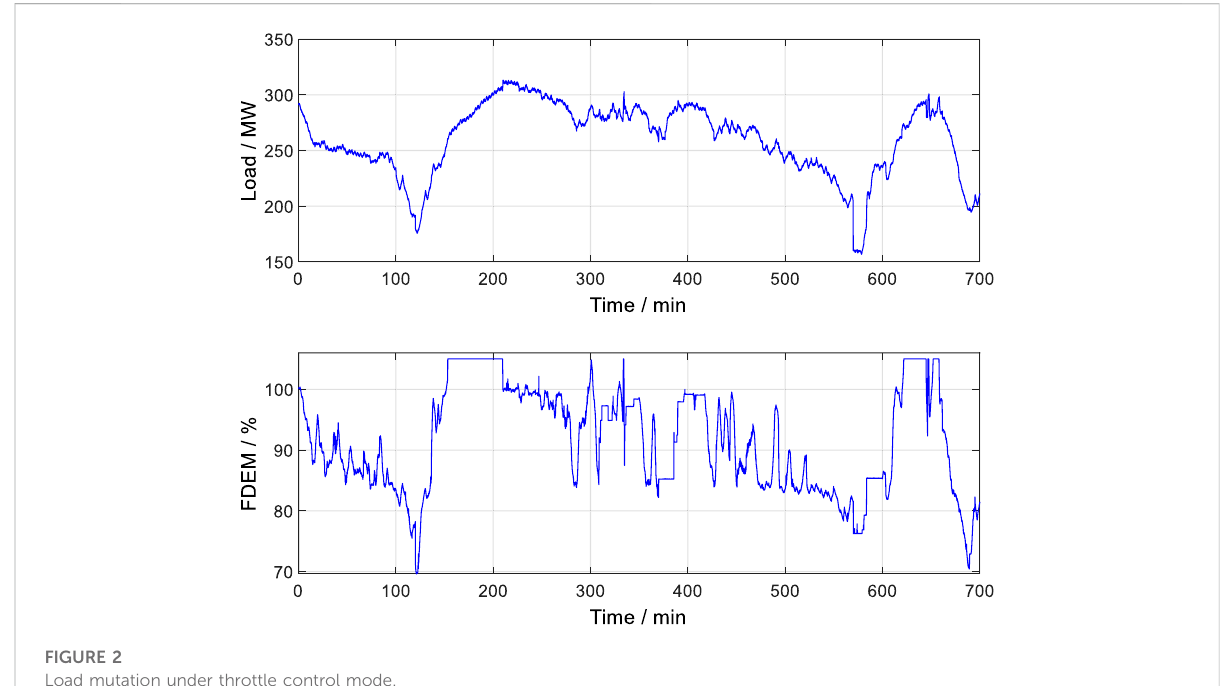
FIGURE 2 Load mutation under throttle control